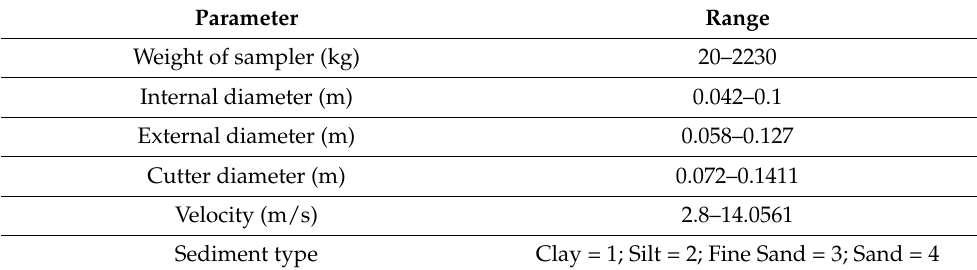
Table 1. Input parameters for gravity corer penetration